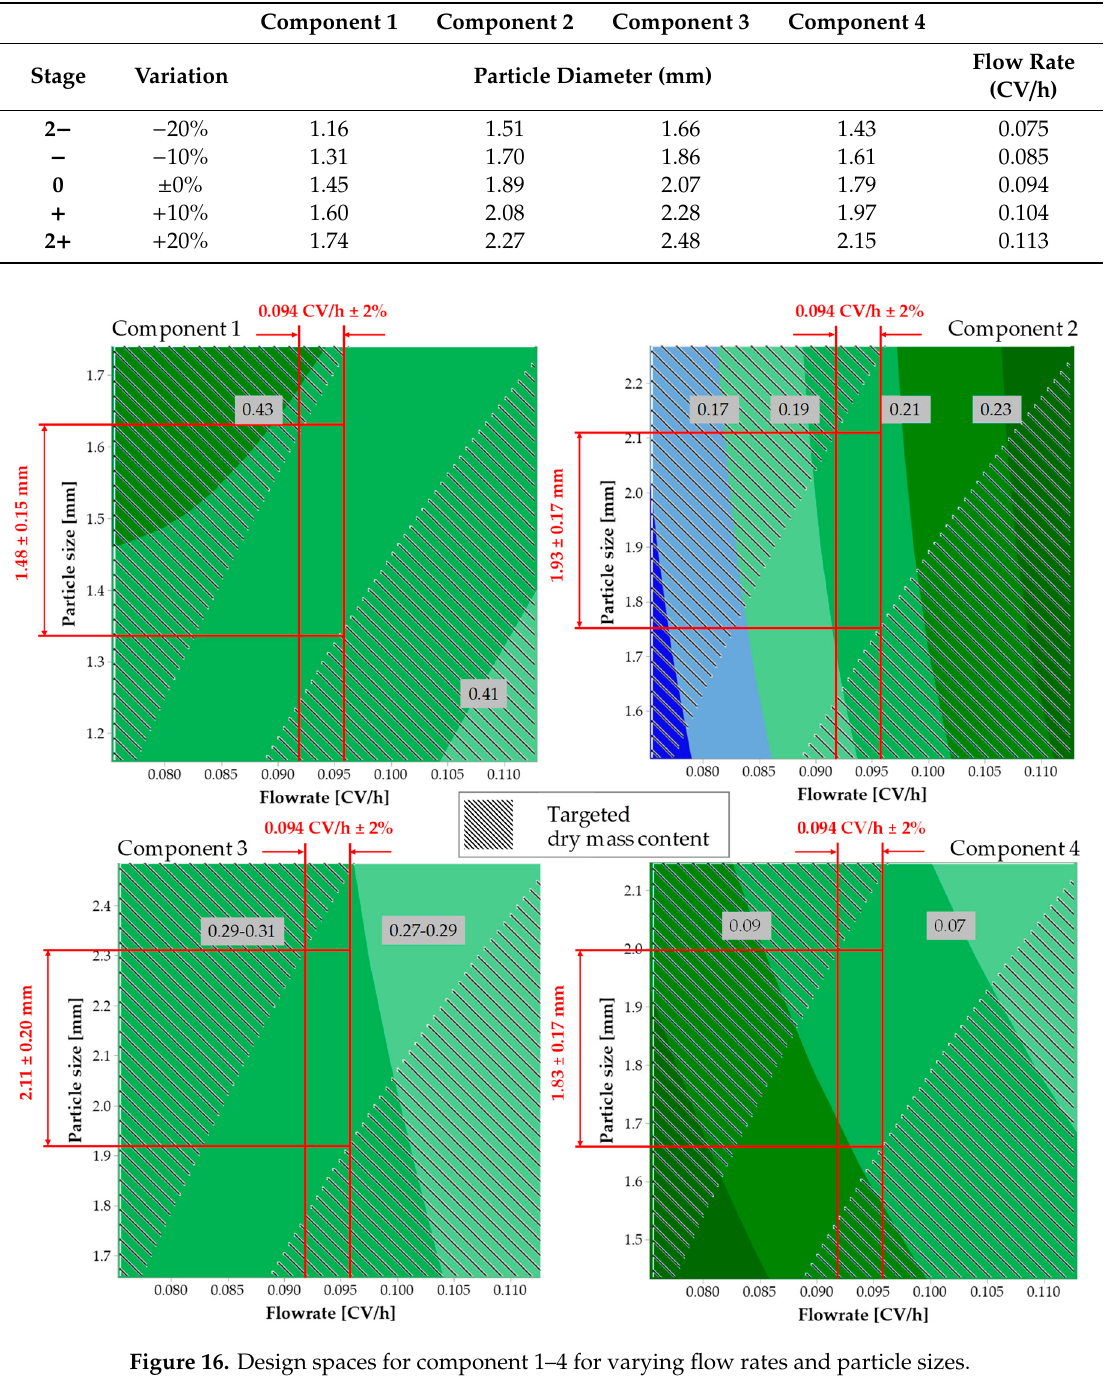
Table 1. Overview of stage values for Design of Experiments (DoE).